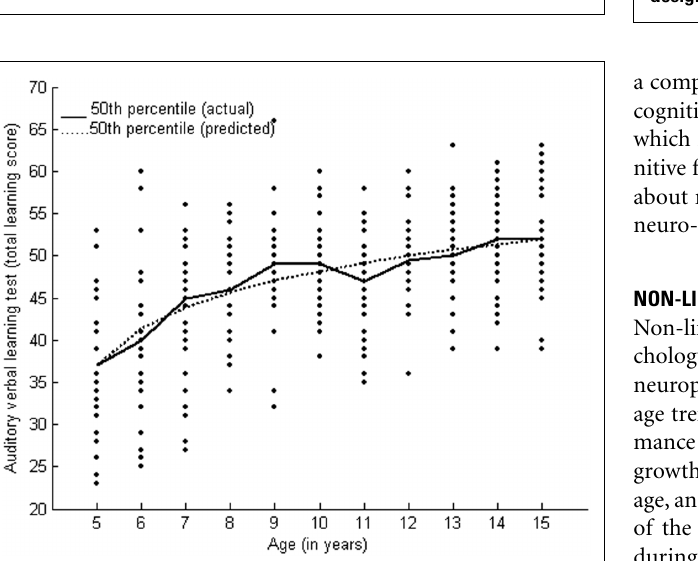
FIGURE 3 | Presents an exemplar of the logistic growth curve for sustained attention.